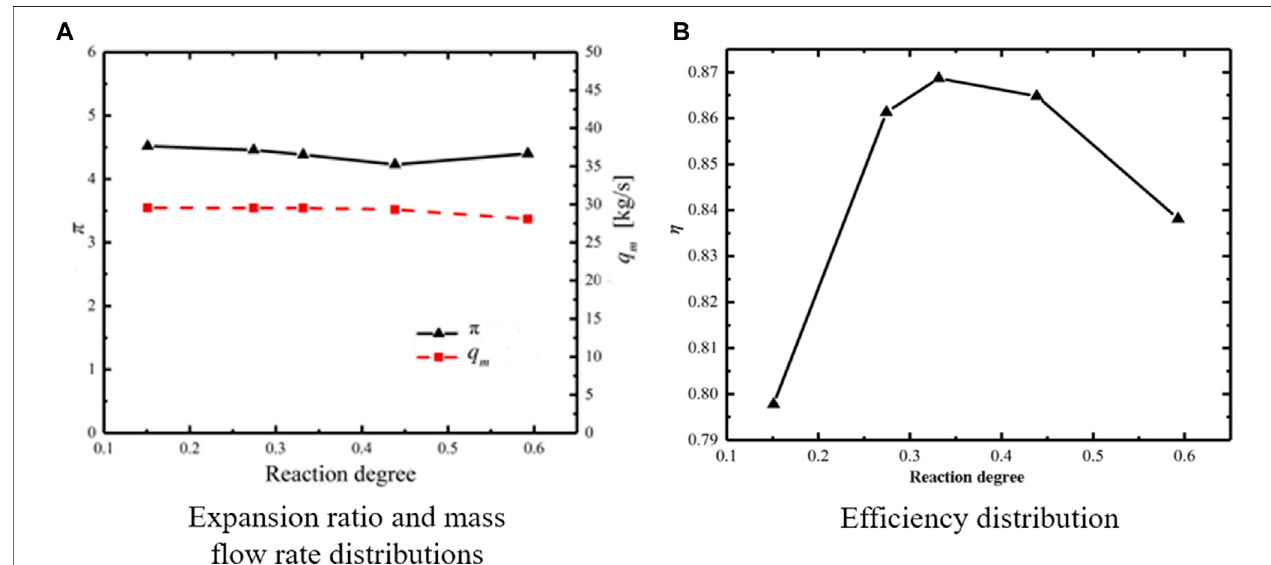
FIGURE 4 | Numerical results for different reaction degrees. (A) Expansion ratio and mass fl ow rate distributions. (B) Ef fi ciency distribution.